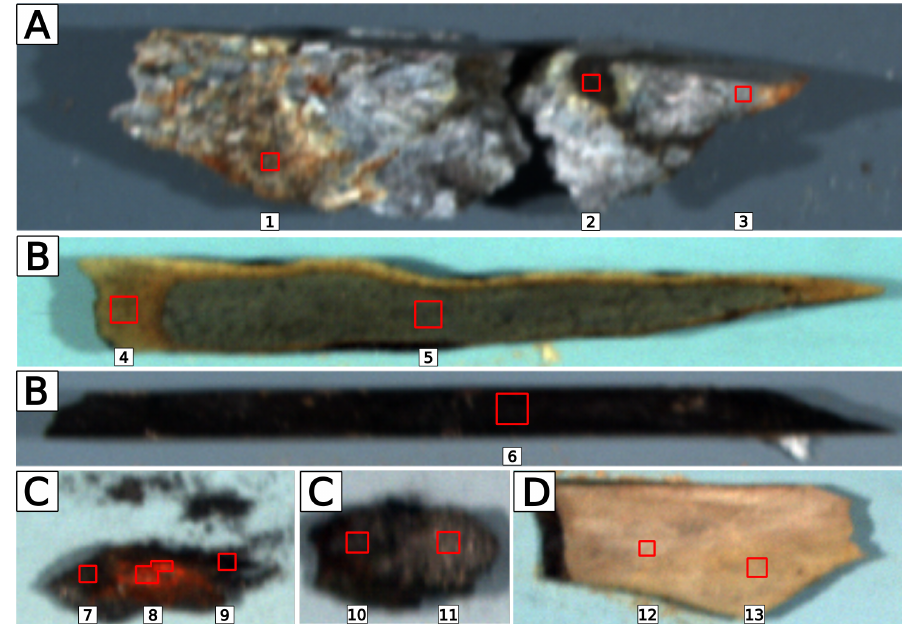
Figure 6. Masks for areas used for reflectance curves. The images are RGB representations of the calculated reflectances with channels taken from 667nm, 540nm, and 470nm, respectively. Each channel was normalised per sample to better visualise within-sample differences. The bounding boxes denotes areas in which measurements were averaged to obtain the spectra. The samples are: ( A ) low-grade SMS sample; ( B ) basalt interior and exterior; ( C ) high-grade SMS; and ( D ) mudstone. The dark region between A-1 and A-2 is